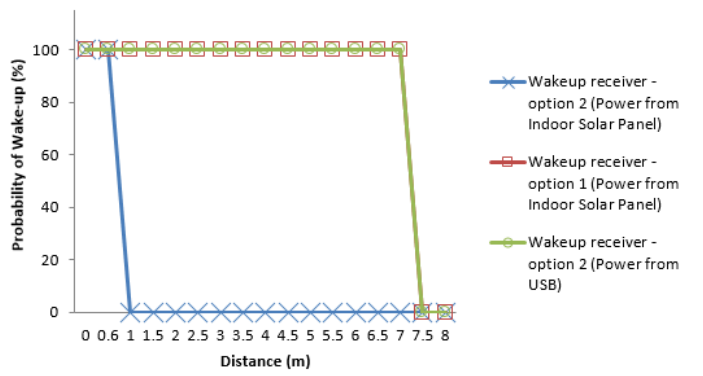
Figure 19. Probability of wake-up vs. distance for the correlator ON for the different receiver configuration under no interference scenario.